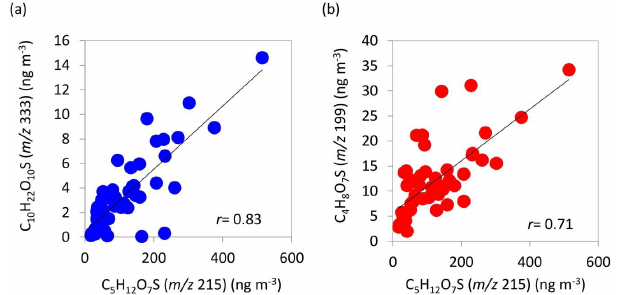
Fig. 3. Correlations between isoprene-derived organosulfates: (a) correlations between IEPOX-derived organosulfate ( m/z 215) and organosulfate derivatives of IEPOX-derived dimers ( m/z 333) support the common isoprene low-NO x pathway and formation mechanisms of these two tracers. (b) Correlations between the IEPOX-derived organosulfate ( m/z 215) and the MAE-derived organosulfate ( m/z 199) suggest similar limiting factors for organosulfate formation, as these two species have been known to form from isoprene photooxidation through low-NO x and high-NO x pathways, respectively.